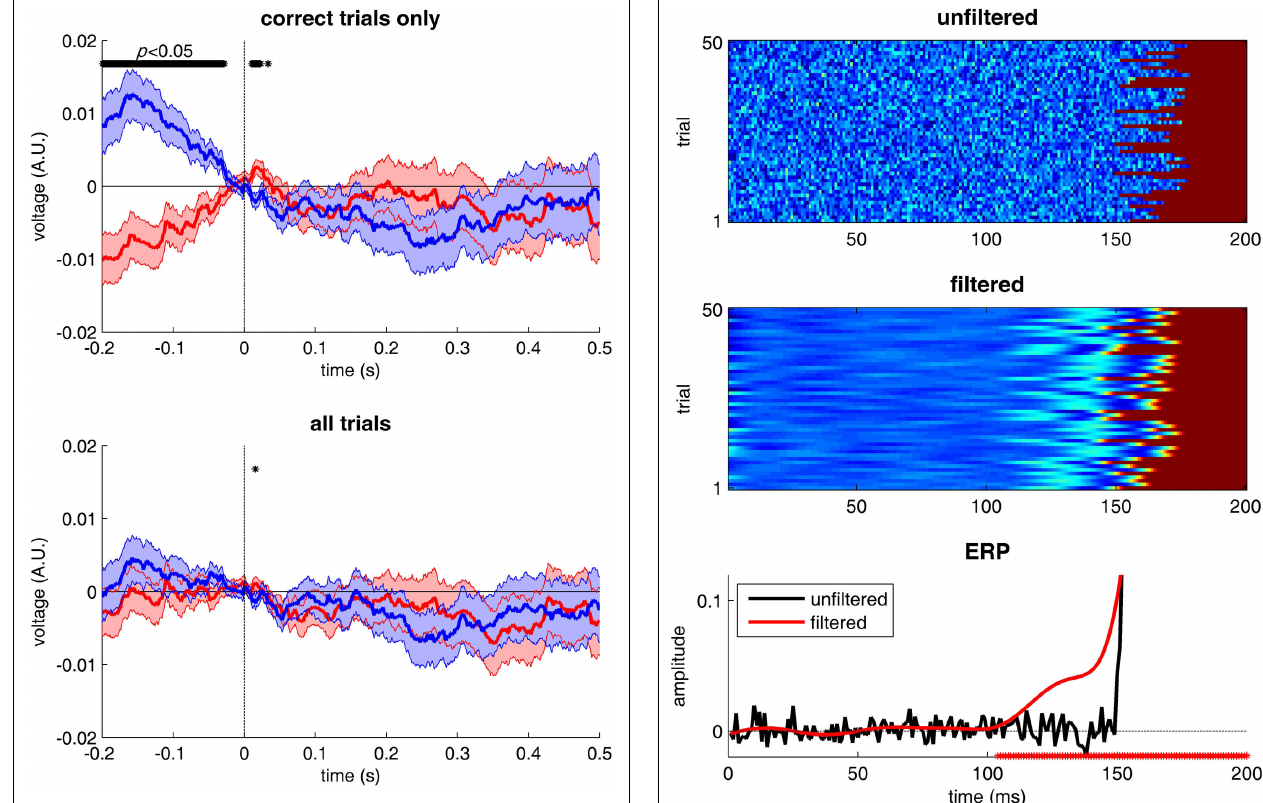
FIGURE 4 |The dangers of filtering. 50 trials of a “fake”EEG signal were simulated. Activity is null until the “onset” of a neural process, occurring at a random time between 150 and 180ms (uniform distribution), after which activity is set to 1. Gaussian-distributed noise (mean 0 and SD of 0.05) is added to all signals. In the top panel, the original trials are stacked vertically and the EEG amplitude is color-coded.The middle panel represents the same trials after low-pass filtering with a 30-Hz cut-off (using the function eegfilt from the EEGLAB software, and its default parameters).The bottom panel illustrates the corresponding ERPs.The red ∗ symbols on the horizontal axis indicate the moments at which the filtered ERPs depart from zero. Even though, by design, the process under study never started before 150ms, its EEG correlates are detected with latencies as early as